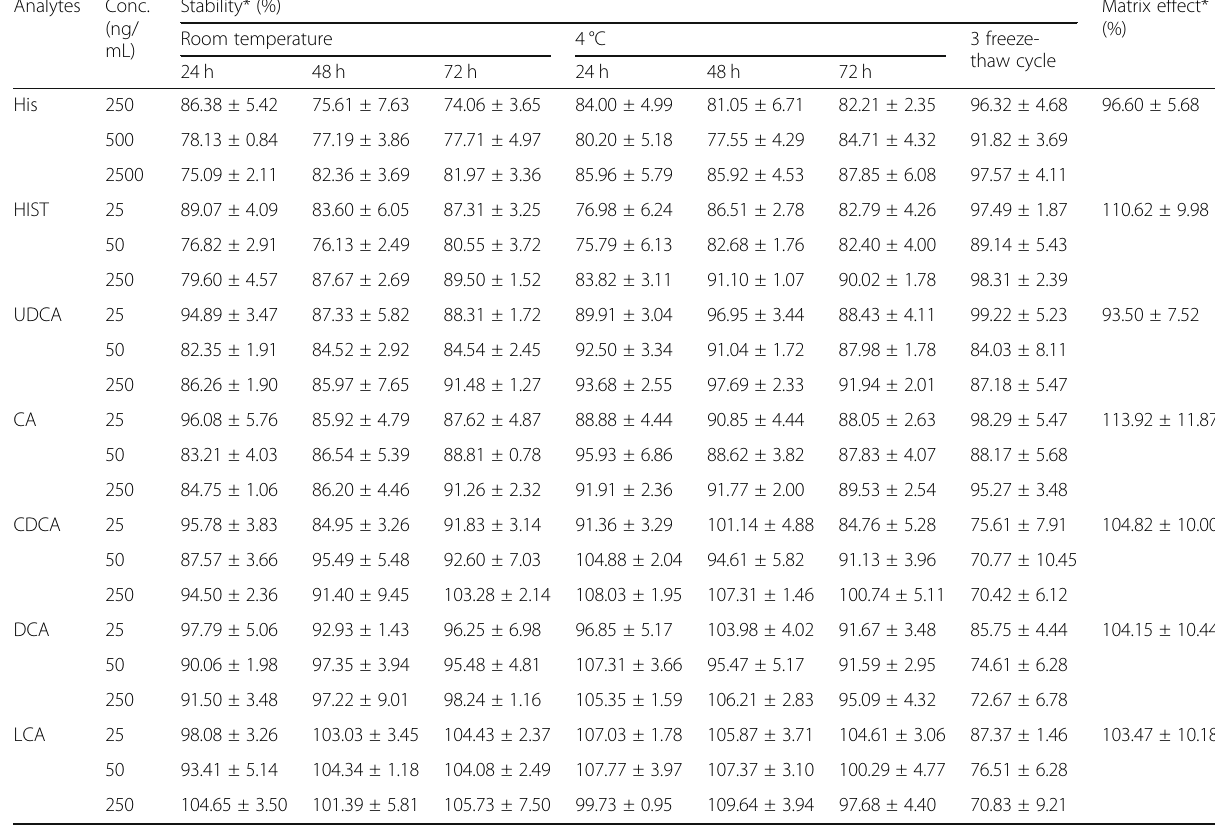
Table 2 Stability and matrix effect of HIST, His, and 5 BAs in spiked gastric fluid sample Analytes Conc. (ng/